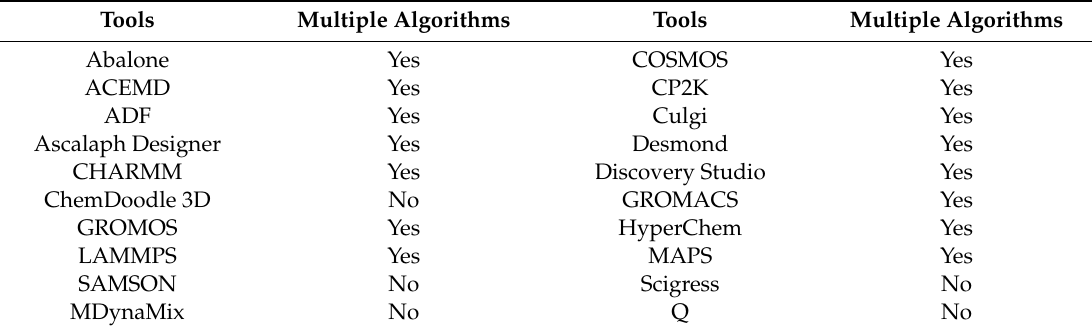
Table 2. Software packages developed based on MD or DSMC and associated methods.